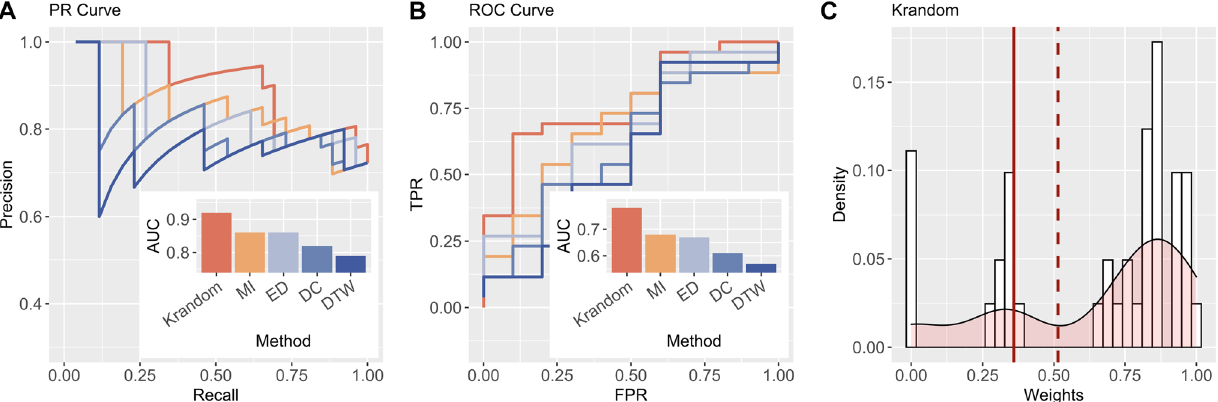
Fig. 7 Topologies and trajectories of the pigeons. A Interaction topology need to infer, B trajectories of the nine pigeons, C topology inferred from K-similarity with GMM-based threshold strategy